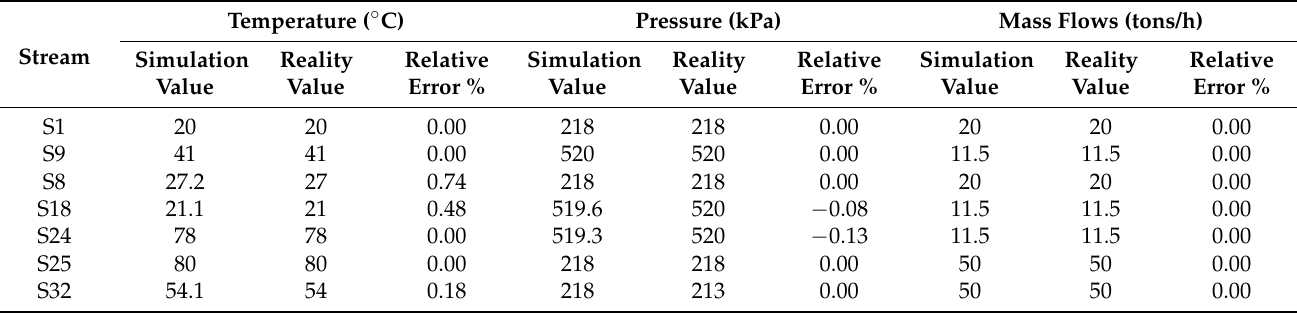
Table 2. Simulation results of the main streams.